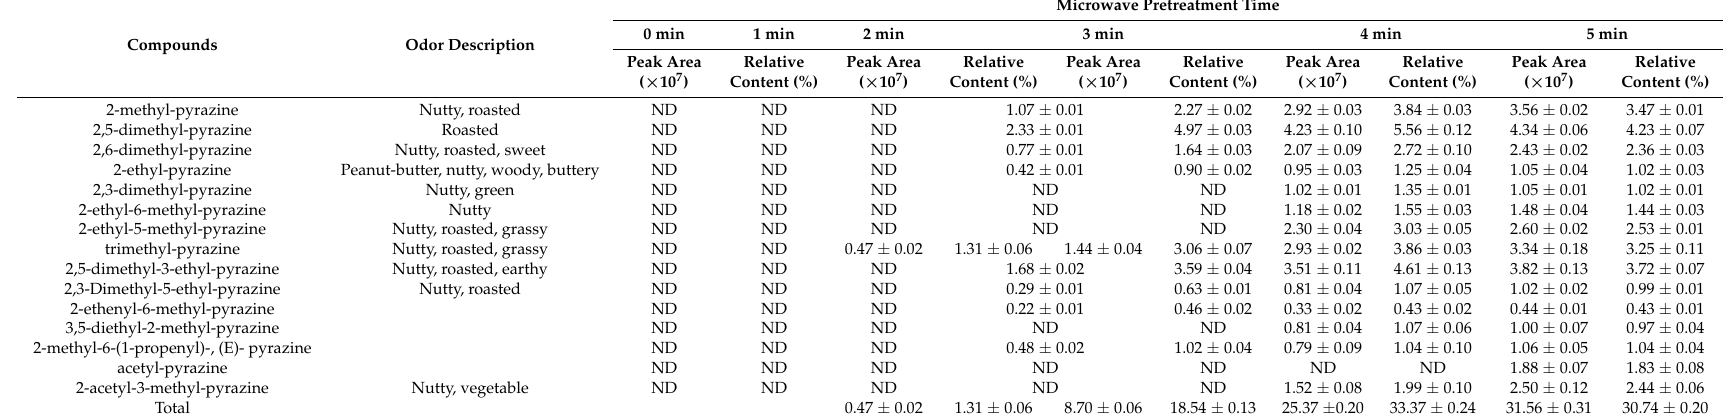
Table 3. Key pyrazine compounds identified using HS-SPME and GC-MS in extracted oil from MW treated and untreated peanut by cold pressing.